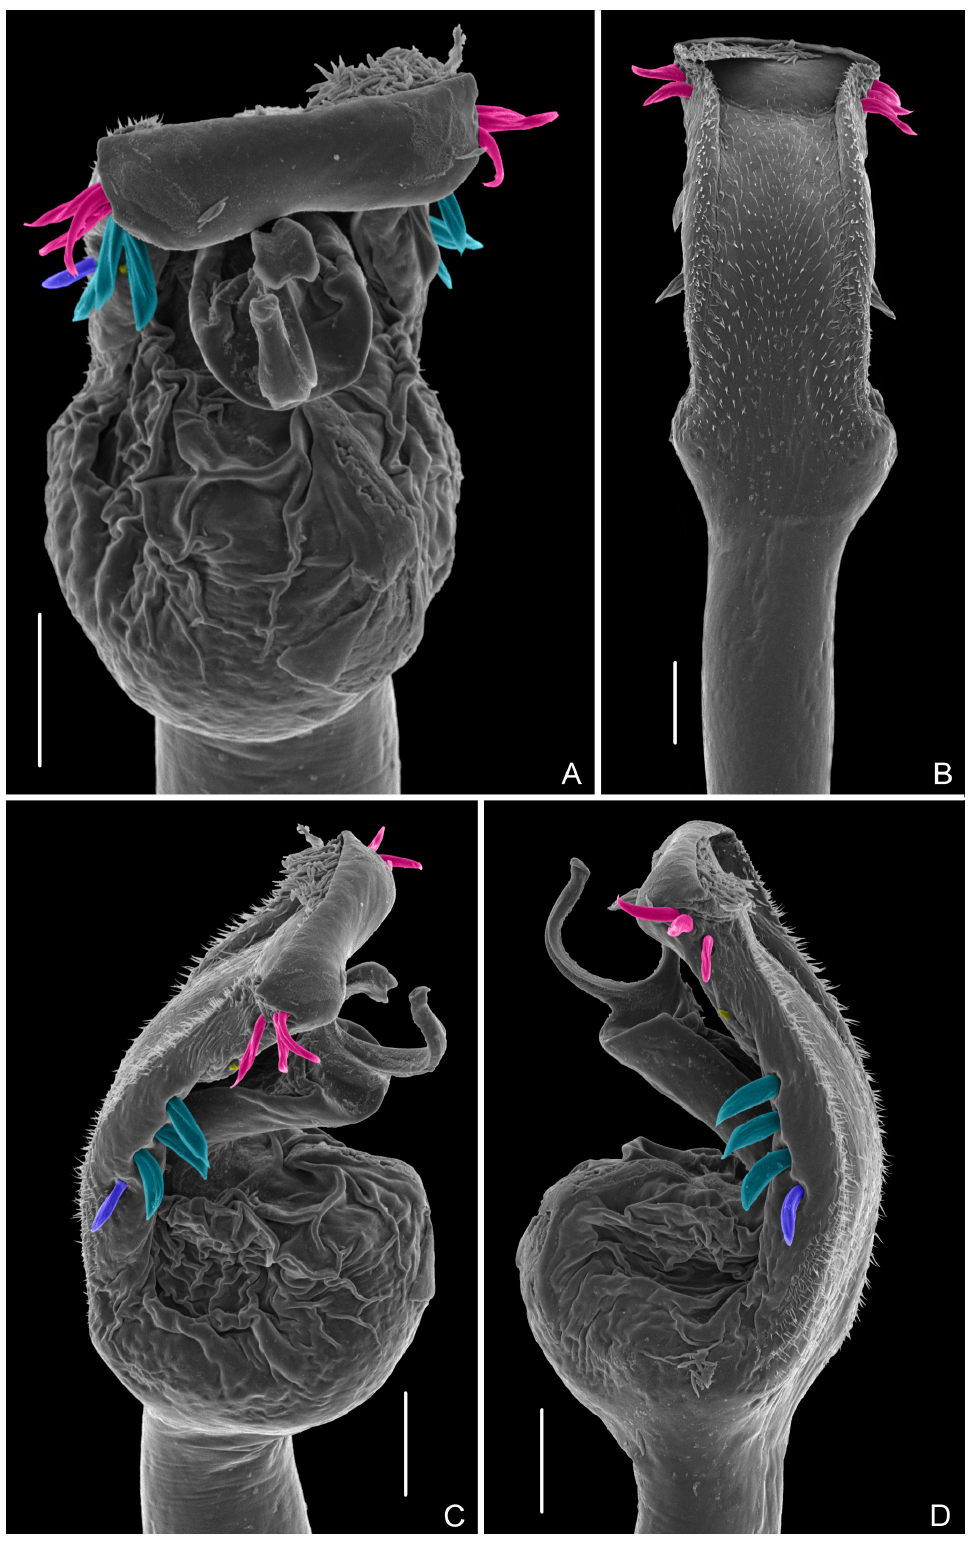
Fig. 6. Eusarcus marmoreus sp. nov., ♂, holotype (ISLA 12968), distal part of penis. A . Dorsal view. B . Ventral view. C . Right lateral view. D . Left lateral view. Macrosetae highlighted in different colours: light blue = MS A; purple = MS B; pink = MS C; yellow = MS D. Scale bars 50